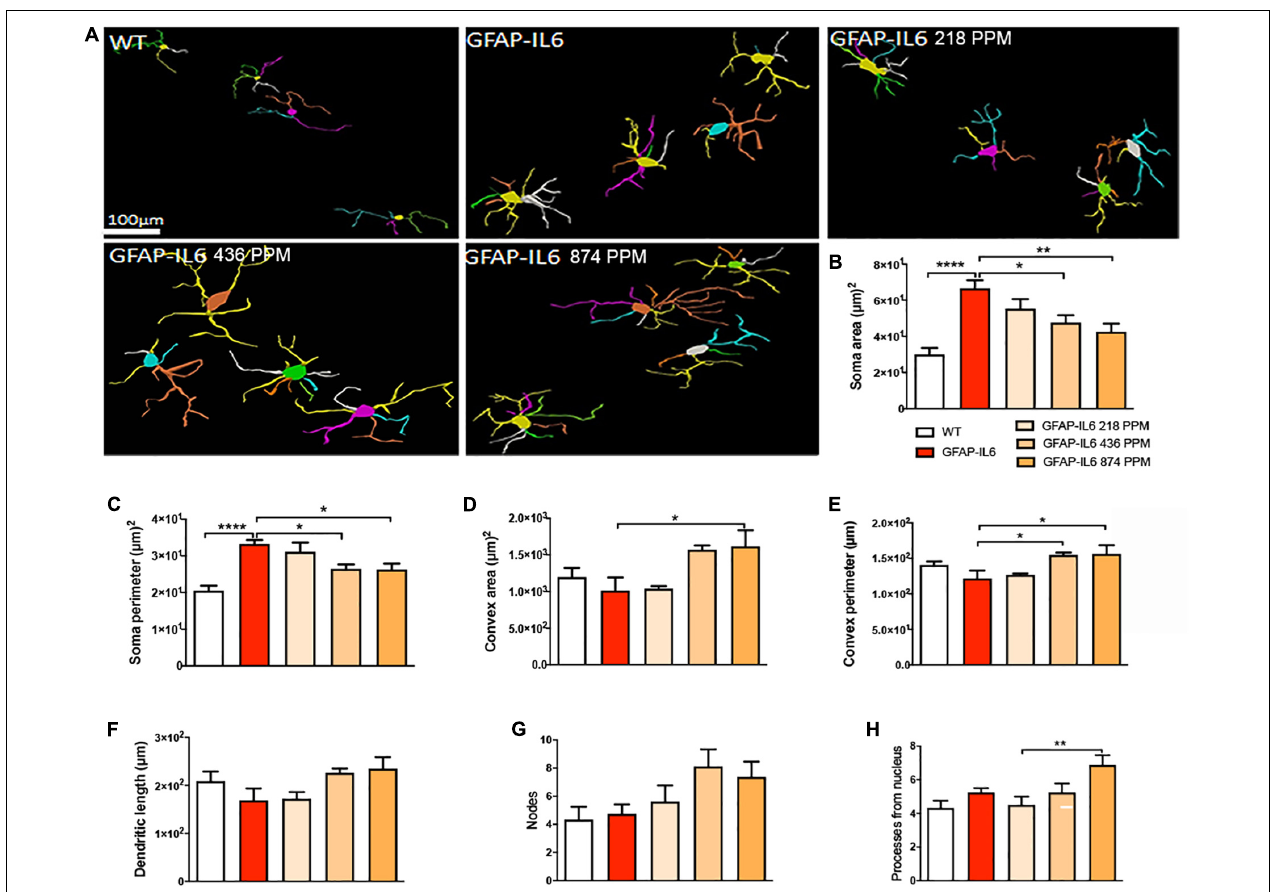
FIGURE 9 | Effect of MC on the morphological characteristics of microglial cells in the cerebellum. (A) Morphological assessment of reactive and non-reactive microglia in the cerebellum. (B–H) In the cerebellum, microglia in the inflamed mice have significantly high soma area and soma perimeter compared with the WT microglia. MC significantly reduced the soma area while, MC high and medium dose with the normal curcumin significantly decreased the soma perimeter, whereas only the high dose MC significantly increase the convex area, convex perimeter, and dendritic length compared with the GFAP-IL6 mice. One-way ANOVA, Tukey’s post-test, Significance = * p < 0.05, ** p < 0.001, **** p < 0.0001, mean ±